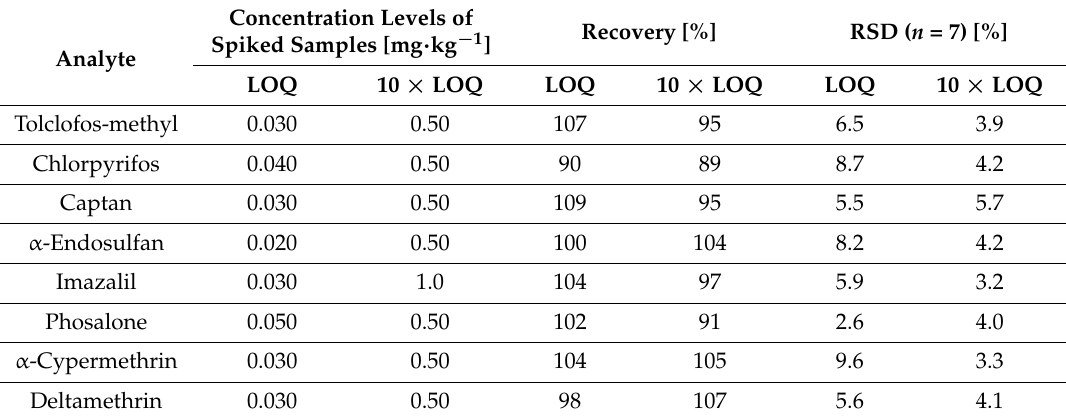
Table 2. Recovery mean values for each pesticide at LOQ and 10 × LOQ spiking